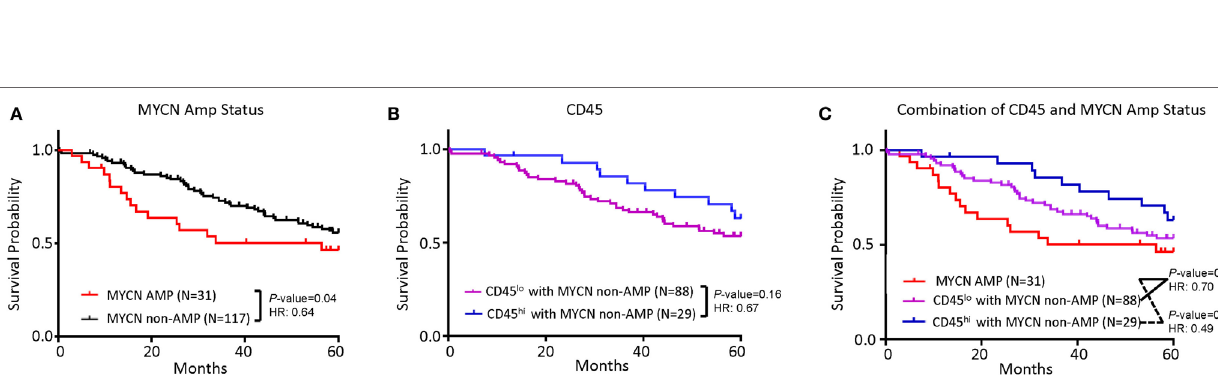
FigUre 1 | MYCN amplification in neuroblastoma (NB) affects inflammatory immune cell phenotypes. (a) MYCN -non-amplified NB samples had greater inflammatory status as defined by CD45 expression (upper panel) and CD45/actin expression ratio (lower panel). (b) The relative abundance of six immune cell types was greater in MYCN -non-amplified tumors than in MYCN -amplified tumors. Statistical significance in (a,b) was determined using Mann–Whitney